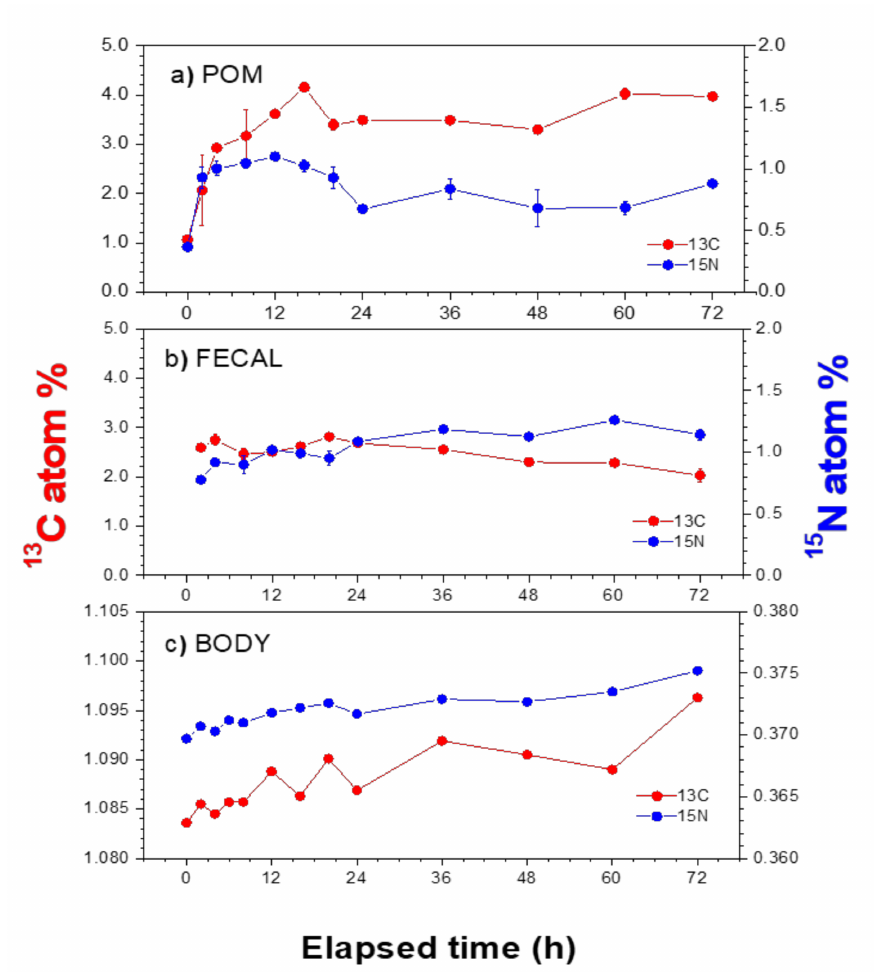
Figure 4. Timely variations of atom% of 13 C and 15 N in particulate organic matter (POM) ( a ), feces and pseudofeces (FECAL) ( b ), and whole body (BODY) ( c ) samples of Unio douglasiae in experimental chambers. The values for BODY are presented as the sum of values for the gills, stomach, gut, mantle, and muscle (standard errors are not